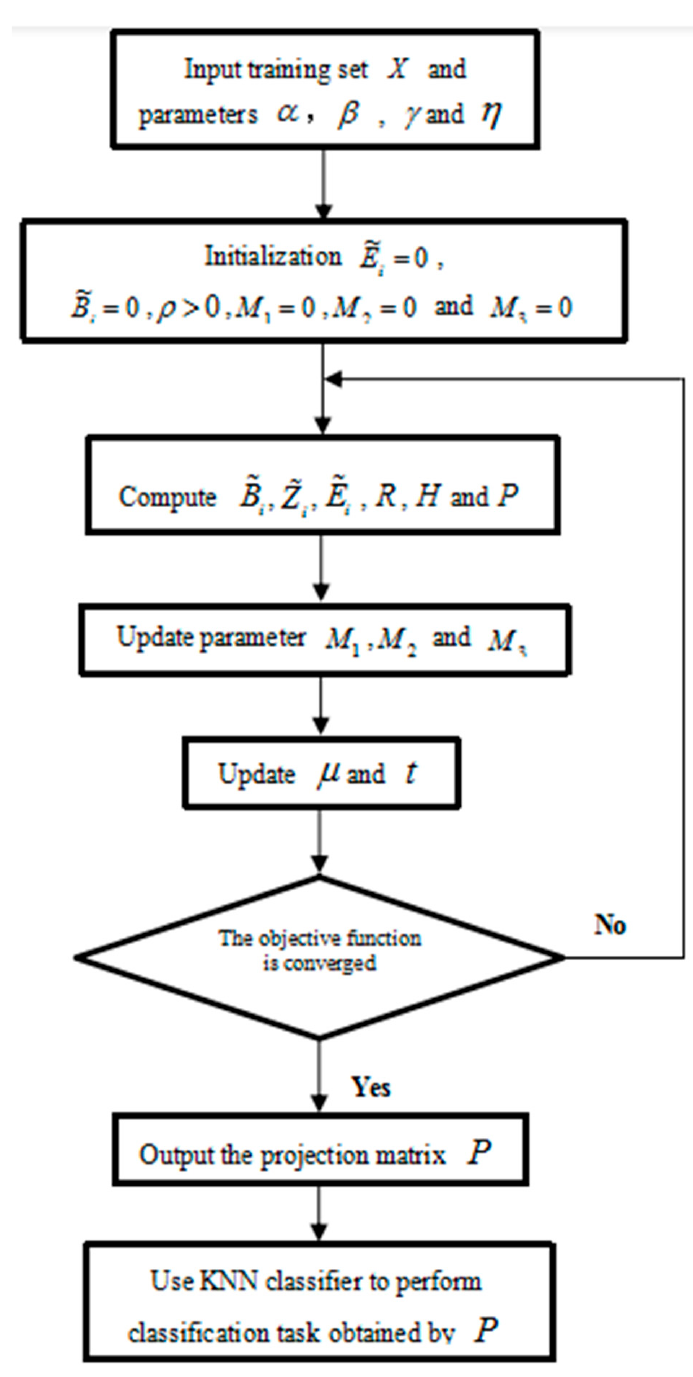
Figure 1. The flow chart of the SILR-2DLDGE method.